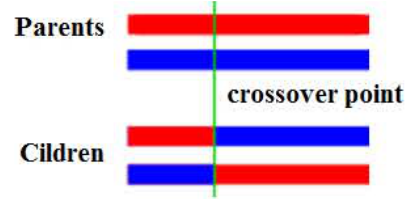
Fig. 5. One-point